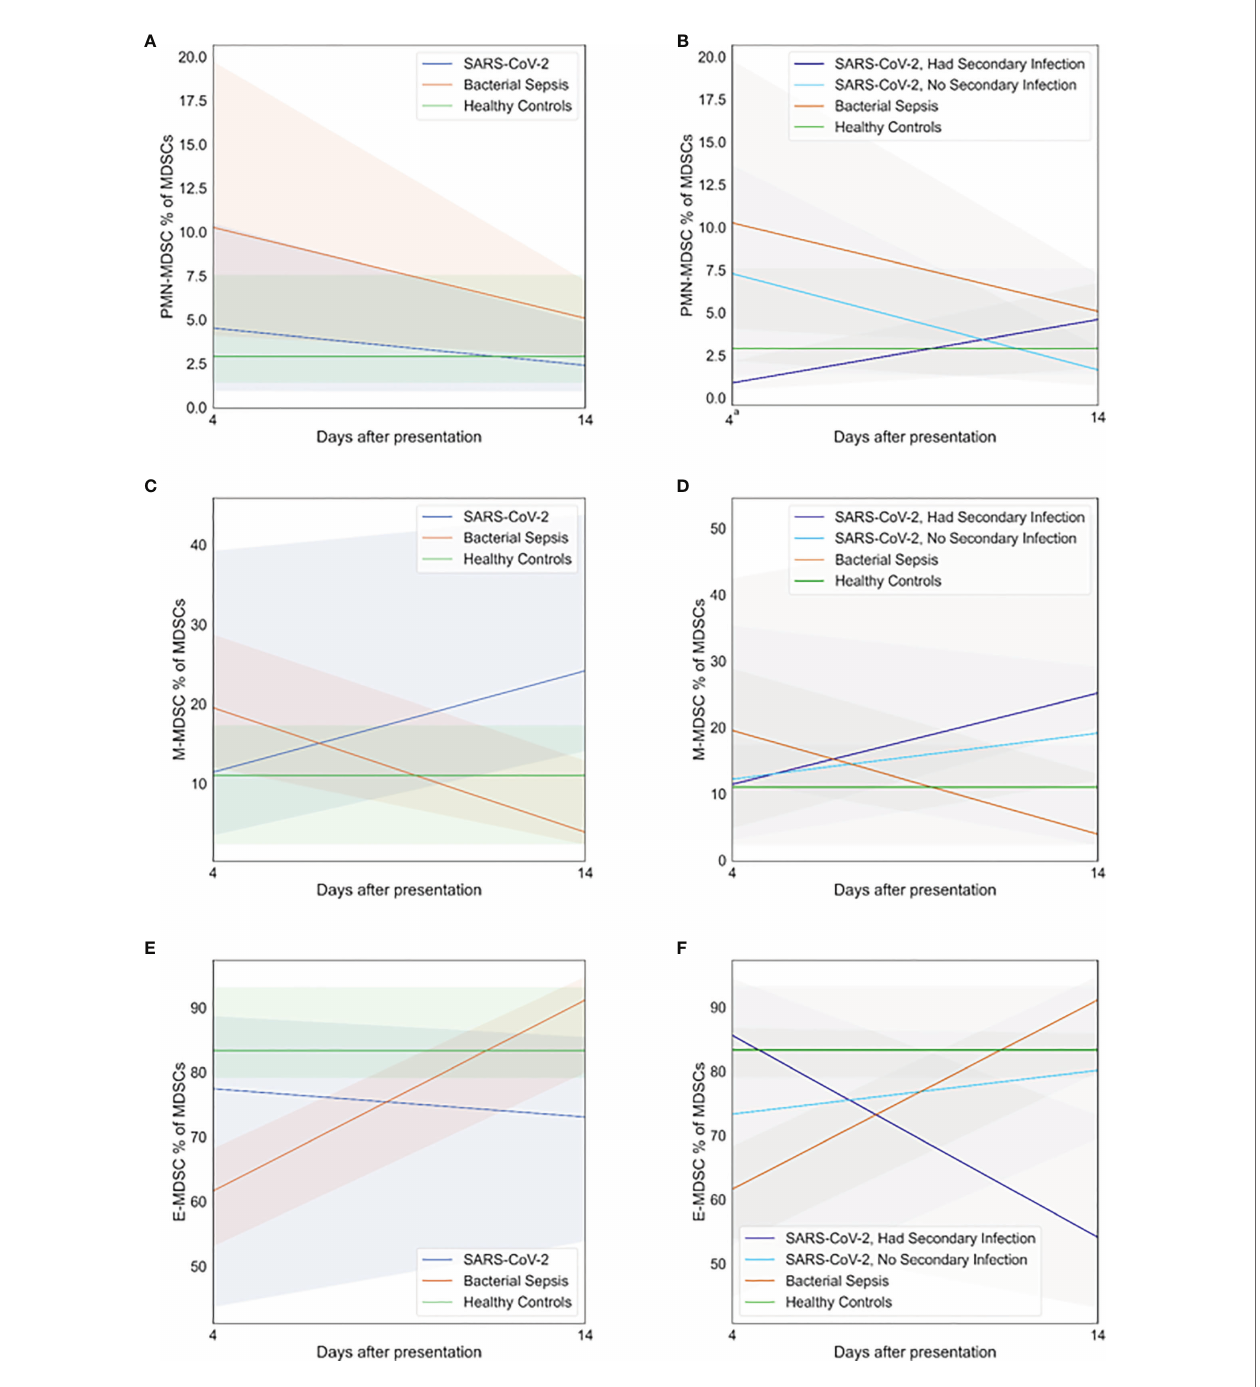
FIGURE 4 | Myeloid-derived suppressor cell (MDSC) pro fi les. Patients with SARS-CoV-2 and secondary bacterial infection had myeloid-derived suppressor cell pro fi les similar to those of healthy controls. Subgroup analyses demonstrated that patients with SARS-CoV-2 who developed secondary bacterial infection had lower proportions of granulocytic (PMN)-MDCSs on day 4 compared with bacterial sepsis (p=0.05). All other proportions of PMN-MDSCs, monocytic (M)-MDSCs, and early progenitor (E)-MDSCs were similar among all groups at all time points. (A) PMN-MDSC on days 4 and 14, primary analysis. (B) PMN-MDSC on days 4 and 14, subgroup analysis. (C) M-MDSC on days 4 and 14, primary analysis. (D) M-MDSC on days 4 and 14, subgroup analysis. (E) E-MDSC on days 4 and 14, primary analysis. (F) E-MDSC on days 4 and 14, subgroup analysis. At each time point, all available values (as listed in Supplemental Table 2 ) were included in all statistical tests for 30 SARS-CoV-2 patients, 10 bacterial sepsis patients, and 10 healthy control patients. Groups were compared by generalized estimating equations with p-values corrected for multiple comparisons by the Benjamini-Hochberg procedure. a p ≤ 0.05 for SARS-CoV-2 with secondary infection vs. Bacterial